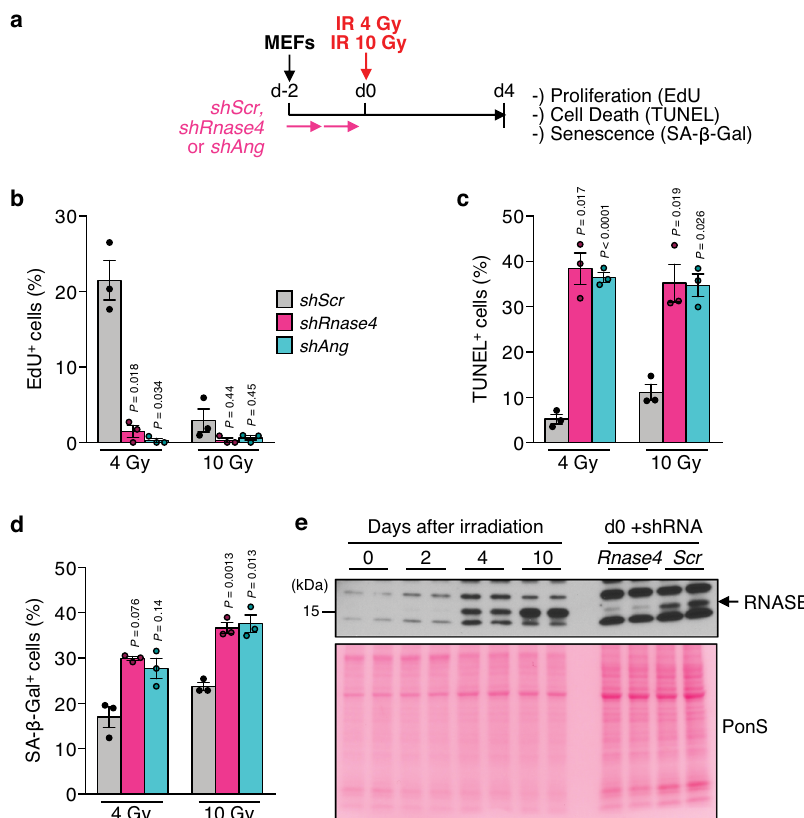
Fig. 6 RNASE4 and ANG regulate cell fate decisions in response to cellular stress. a Experimental approach to assess indicated cell fates after Rnase4 or Ang knockdown under stress conditions via 4 Gy or 10 Gy (senescence-inducing amount) of irradiation in MEFs. b Proportion of EdU-positive cells. Cells were allowed to incorporate EdU into their DNA for 24 h. c TUNEL assay quanti fi cation to assess the proportion of dying cells. d Quanti fi cation of cells positive for senescence-associated β -galactosidase (SA- β -Gal). e Western blot analysis of RNASE4 in MEF lysates harvested at the indicated time points after irradiation. Western blot result is representative of 3 independent experiments. Rnase4 knockdown lysates were assessed in parallel as control. Ponceau S (PonS) staining served as loading control. Data represent means ± SEM. n = 3 independent MEF lines from 1 experiment in b – d . Statistics: one- way ANOVA with Sidak ’ s correction in b – d . Source data are provided as a Source Data fi